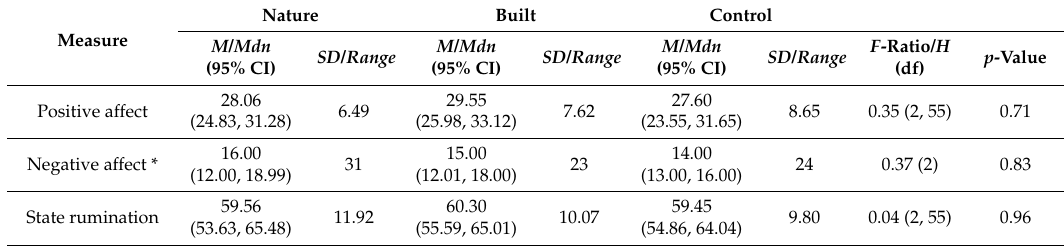
Table A2. Descriptive Statistics and Results of Tests of Differences at Post-Presentation by